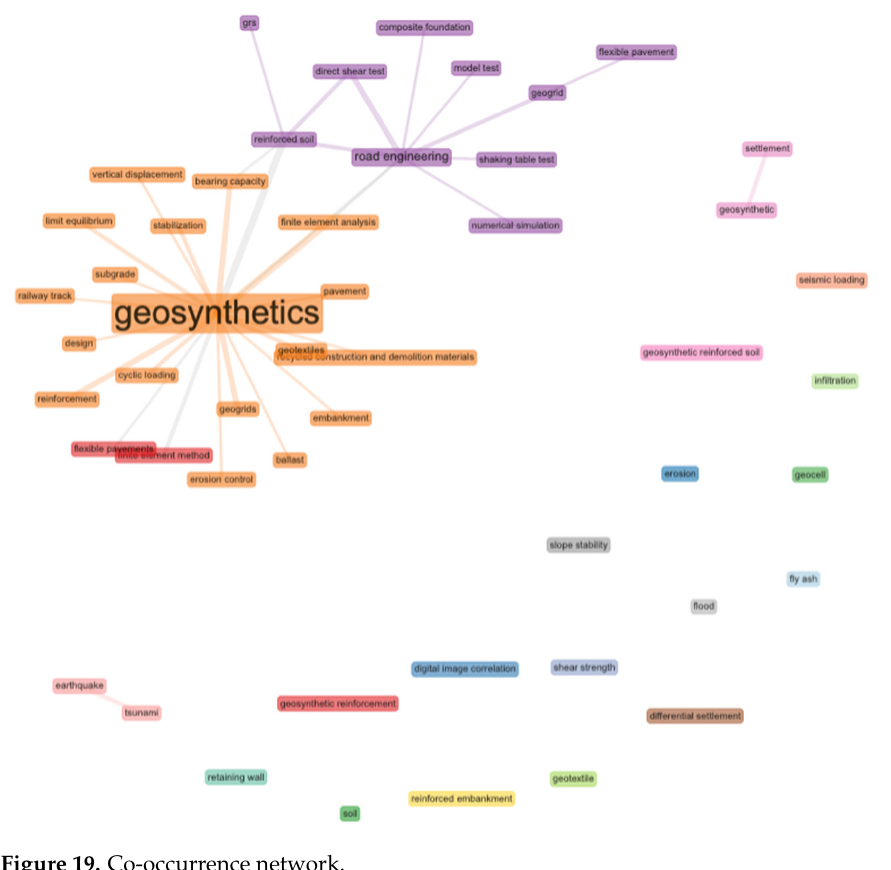
Figure 19. Co-occurrence network.